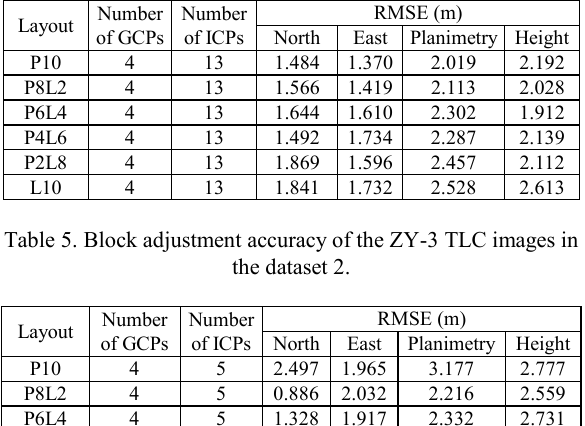
Table 4. Direct georeferencing accuracy of the ZY-3 TLC images in the dataset 3.